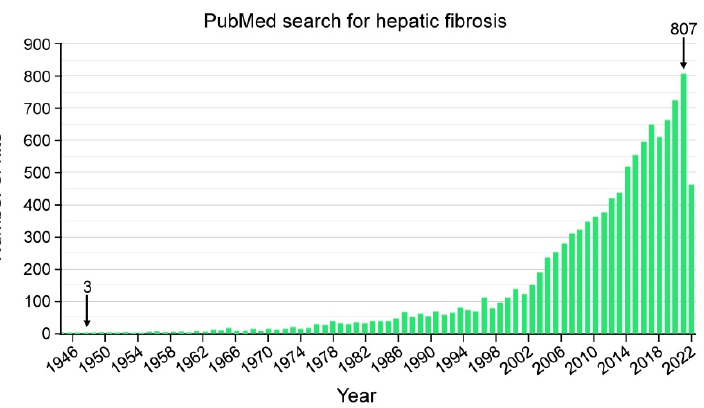
Figure 1. PubMed search for the query “hepatic fibrosis”. This example search documents that this research area has found increasing interest during the last decades. Whereas with the search term “hepatic fibrosis” only 3 hits can be found for the year 1948, there were already 807 entries in the year 2021. Especially after the turn of the millennium, the number of publications in this field has increased dramatically. Please note that the year 2022 only covers the time interval from January to the end of July.